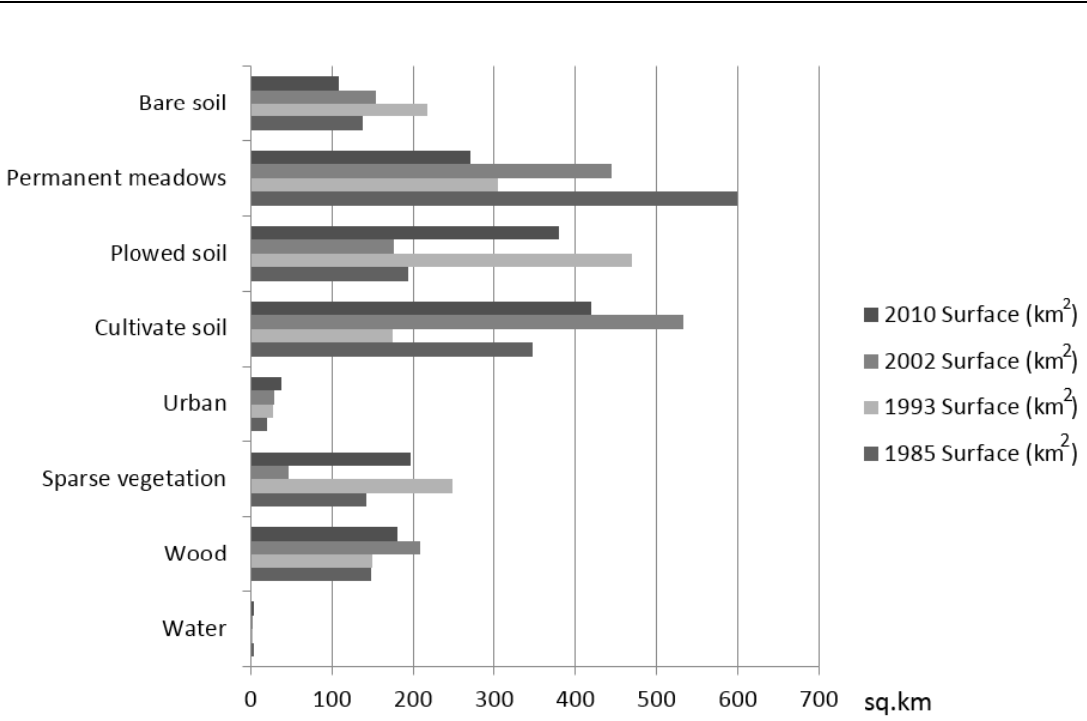
Figure 6. Comparison of areas for each class in 1985, 1993, 2002 and 2010, respectively.